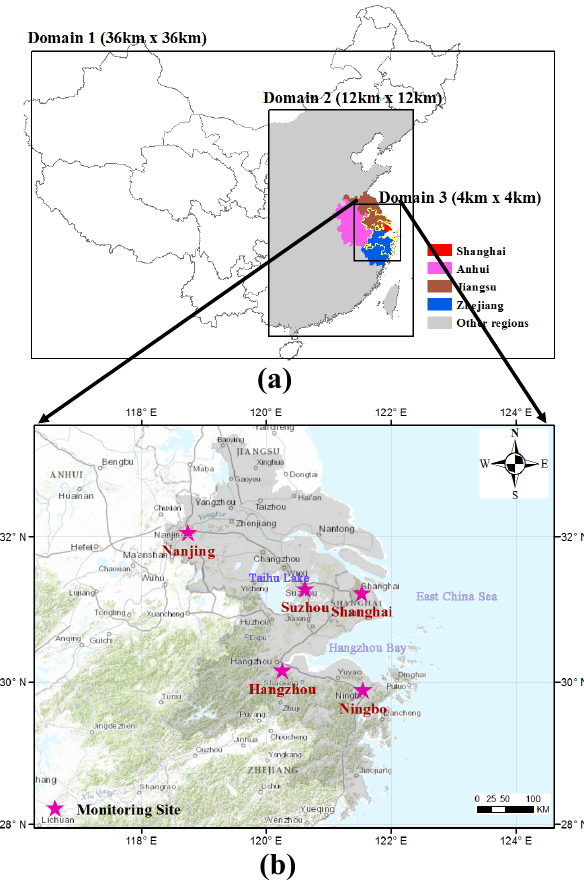
Fig. 1. Model domain and location of measurement sites. (a) Three nested domain grids for WRF/CMAQ modeling. (b) Location of field monitoring sites. The yellow border in (a) and gray area in (b) constitute the YRD region. The five regions indicated by different colors in panel (a) were used for WRF/CMAQ sensitivity analyses, with biomass burning emissions set to zero in each region to determine their effects on concentrations of PM 2.5 and carbon species.